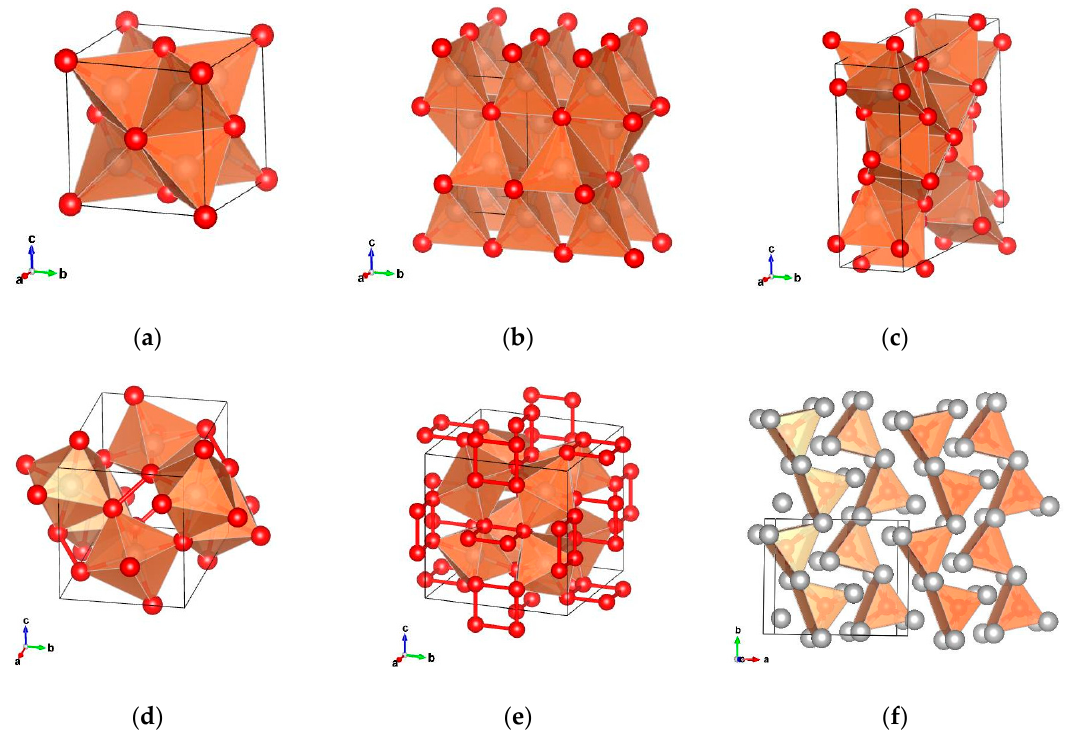
Figure 1. The structure of selected platinum group metal (PGM) phosphides. The metal atoms are displayed in grey and the phosphorus atoms in red. ( a ) Rh 2 P crystallizes in the anti-CaF 2 structure; ( b ) Rh 2 P 3 ; ( c ) Rh 4 P 3 ; ( d ) RhP 2 crystallizes in the CoSb 2 structure forming P 2 dimers; ( e ) RhP 3 crystallizes in the CoAs 3 structure forming Rh 4 − 4 rings; ( f ) the Co 2 P structure with chains of slightly distorted